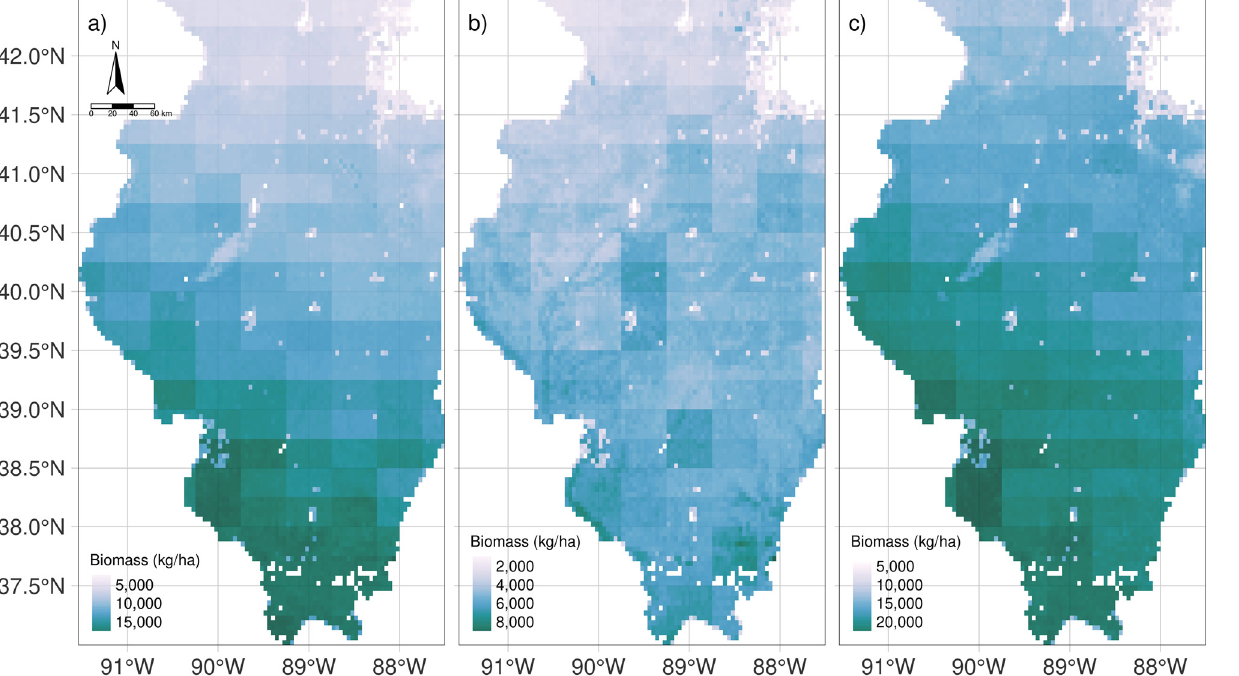
Figure 4. Average cereal rye biomass (kg ha − 1 ) across the state of Illinois for ( a ) corn-rye-corn-rye, ( b ) rye preceding corn in corn-rye-soybean-rye, and ( c ) rye preceding soybean in corn-rye-soybean-rye rotation.